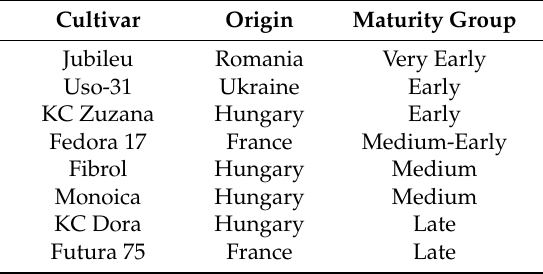
Table 1. Main characteristics of the eight monoecious cultivars utilized in the